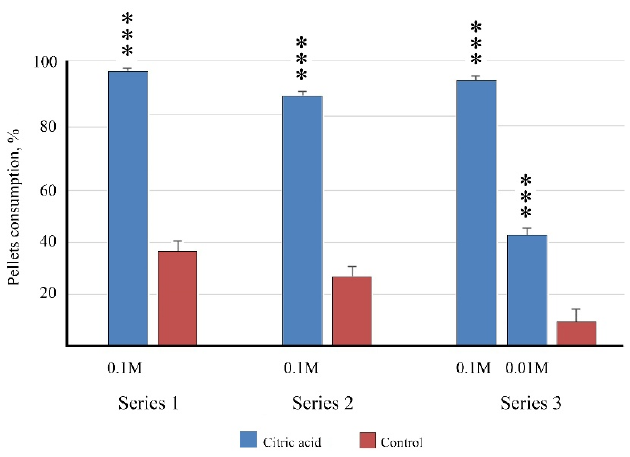
Figure 4. Palatability of agar gel (2%) pellets flavored with citric acid for barramundi Lates calcarifer juveniles in different series of trials. ***—differences from the control are significant at p < 0.001 ( χ 2 ‐ test). Whiskers are the s.e.m.